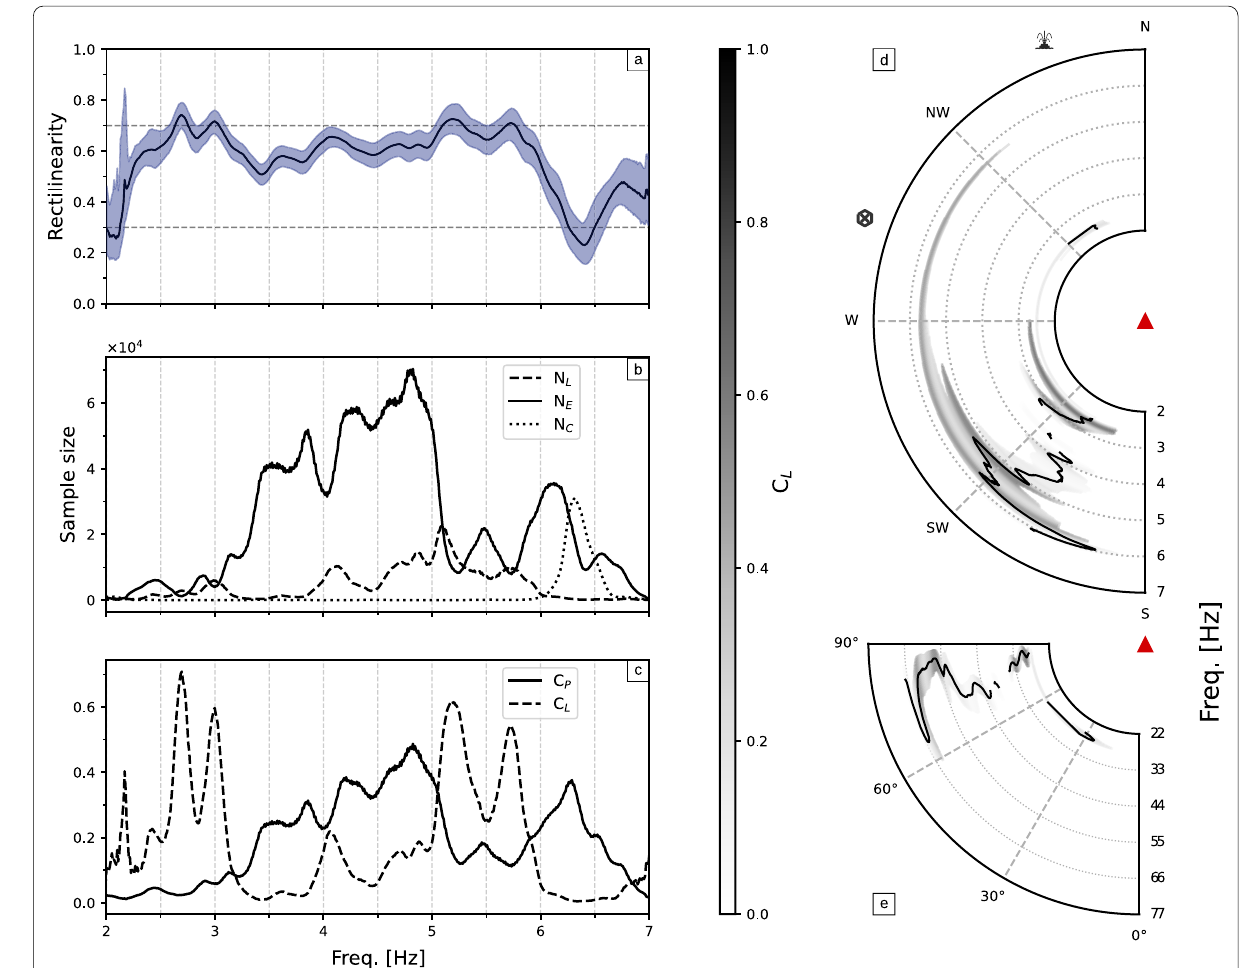
Fig. 9 Polarization analysis of 226 BB tremor episodes. We excluded 44 episodes due to gaps or/and corrupted data in some of the three components. a The 25th, 50th (black line), and 75th percentiles of R when PD (cid:31) 0.8 . b The sample size of R in function of the frequency and polarization class: linear ( N L ), elliptical ( N E ), and circular ( N C ). c The polarization coefficients C P and C L in function of the frequency. d The 25th, 50th (black line), and 75th percentiles of horizontal azimuth (cid:31) H and (e) vertical incidence (cid:31) V in function of C L when the sample size is greater than 10